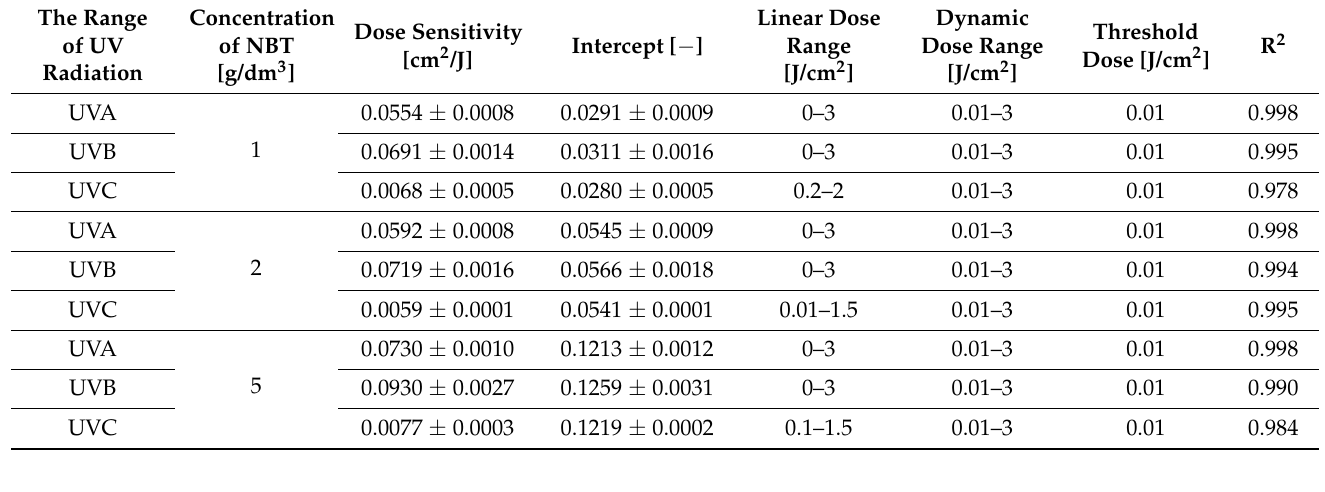
Table 1. Basic characteristics of NBT-Pluronic F-127 gels with various concentrations of NBT and irradiated with UVA, UVB and UVC radiation.